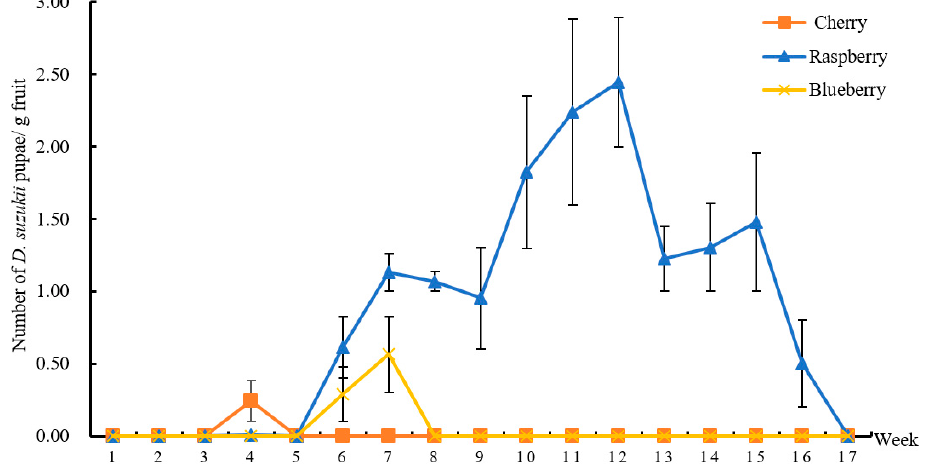
Figure 8. Weekly mean number of D. suzukii pupae/g fruit in different fruits. Weeks 1–17 start from